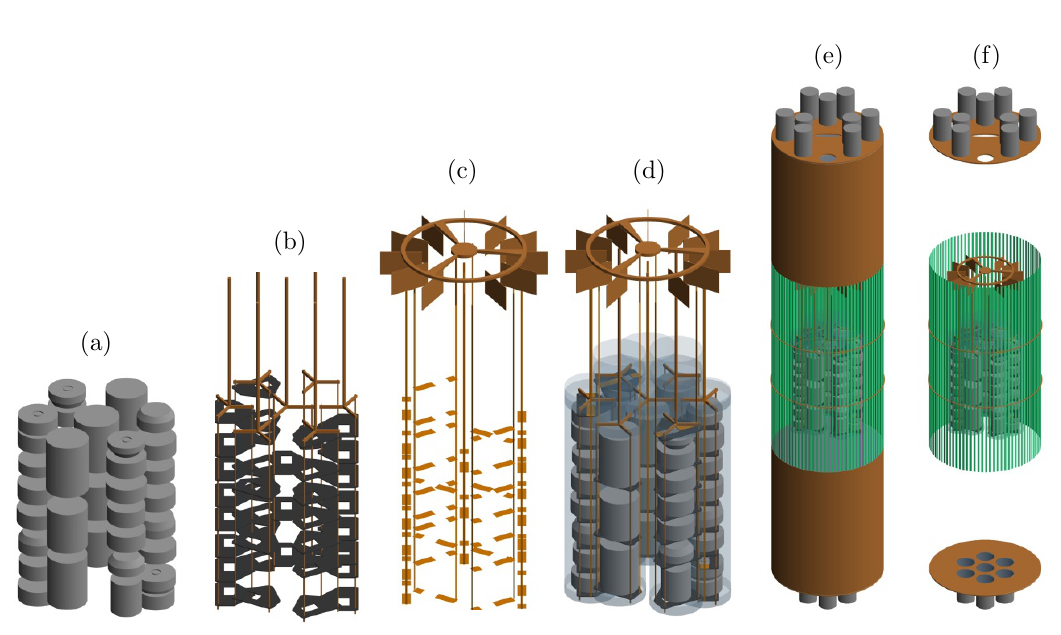
Figure 1. Implementation of the Gerda array in MaGe , visualized using the Geant4 visualiza- tion drivers. From left to right: a) the Gerda detectors, b) the holder mounting, composed of silicon plates and copper bars c) the high-voltage and signal (cid:13)exible (cid:13)at cables plus the front-end electron- ics on top, d) the full array instrumentation, including the transparent nylon mini-shrouds, e) the full LAr veto system surrounding the array, including the (cid:12)ber shroud (in green), the Tetratex R (cid:13) - coated copper shrouds (above and below the (cid:12)bers) and the two PMT arrays, f) the LAr veto system without the copper